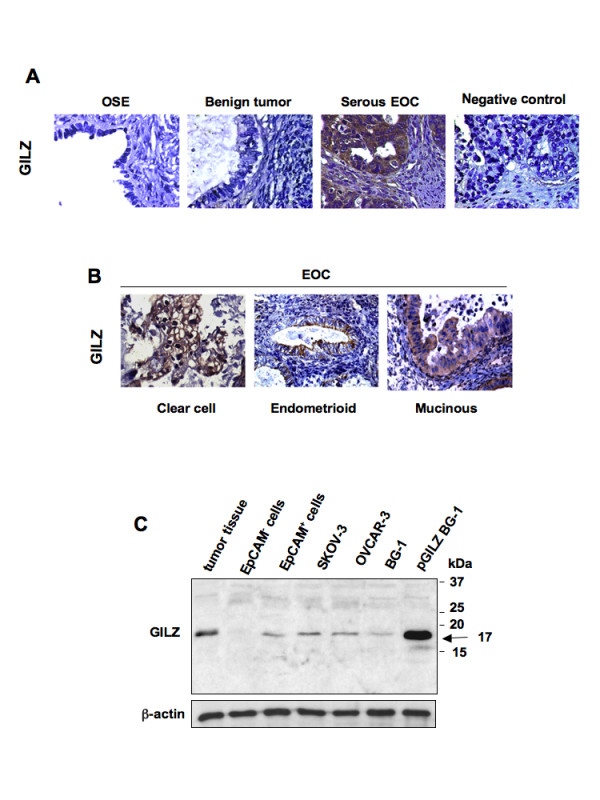
GILZ detection in epithelial ovarian cancer (EOC). (A) GILZ immunostaining in ovarian surface epithelium of normal ovaries (OSE), benign tumors, invasive serous ovarian carcinoma. Negative control was done without primary Ab. Original magnification, ×63. (B) Cytoplasmic GILZ immunostaining in clear cell, endometrioid and mucinous EOC. Original magnification, ×40. (C) GILZ immunoblots of total protein lysates from ovarian cancer tissue (representative data from several frozen tumor specimens), malignant ascites processed by the autoMacs procedure to separate EpCAM+ cells identified as epithelial cells from EpCAM- cells, from ovarian cancer cell lines SKOV-3, OVCAR-3 and BG-1. BG-1 cells stably transfected with GILZ-encoding vector pcDNA3-GILZ (pGILZ) was used as positive control (17 kDa). Actin levels are shown for normalization. Data are representative of three different experiments.